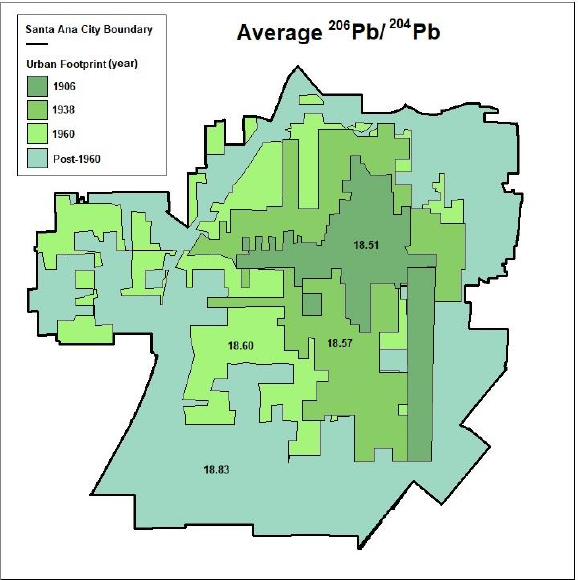
Figure 7. Historical urban footprints in Santa Ana and the average 206 Pb/ 204 Pb ratio across soil samples collected within each region. Table 1. Lead concentrations and isotopic ratios averaged by spatial groupings.